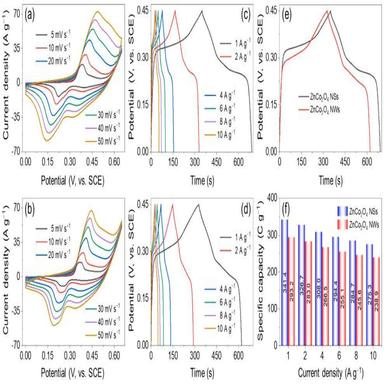
CV curves of (a) ZnCo2O4 NSs and (b) ZnCo2O4 NWs at different scan rates, GCD curves of (c) ZnCo2O4 NSs and (d) ZnCo2O4 NWs at different current densities, (e) GCD curves of ZnCo2O4 NSs and ZnCo2O4 NWs at 1 A g− 1 , and (f) rate performance of ZnCo2O4 NSs & NWs.